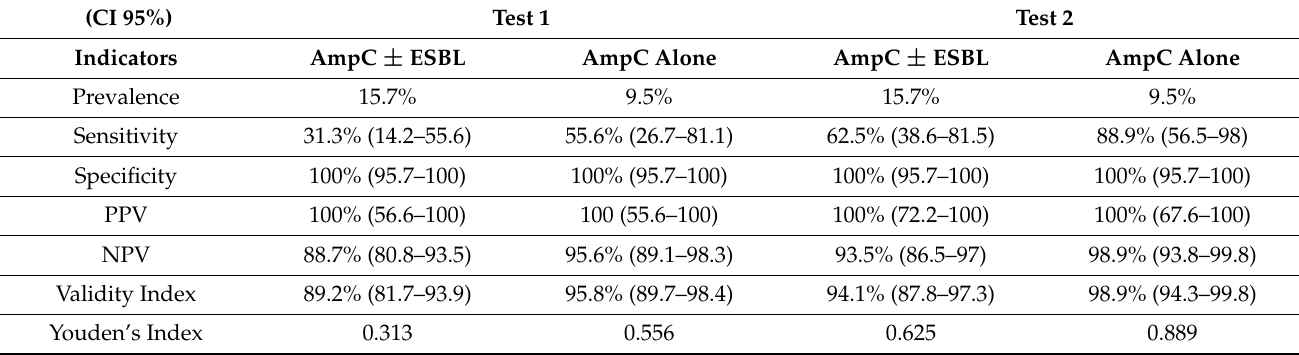
Table 8. Usefulness of screening methods with tests 1 and